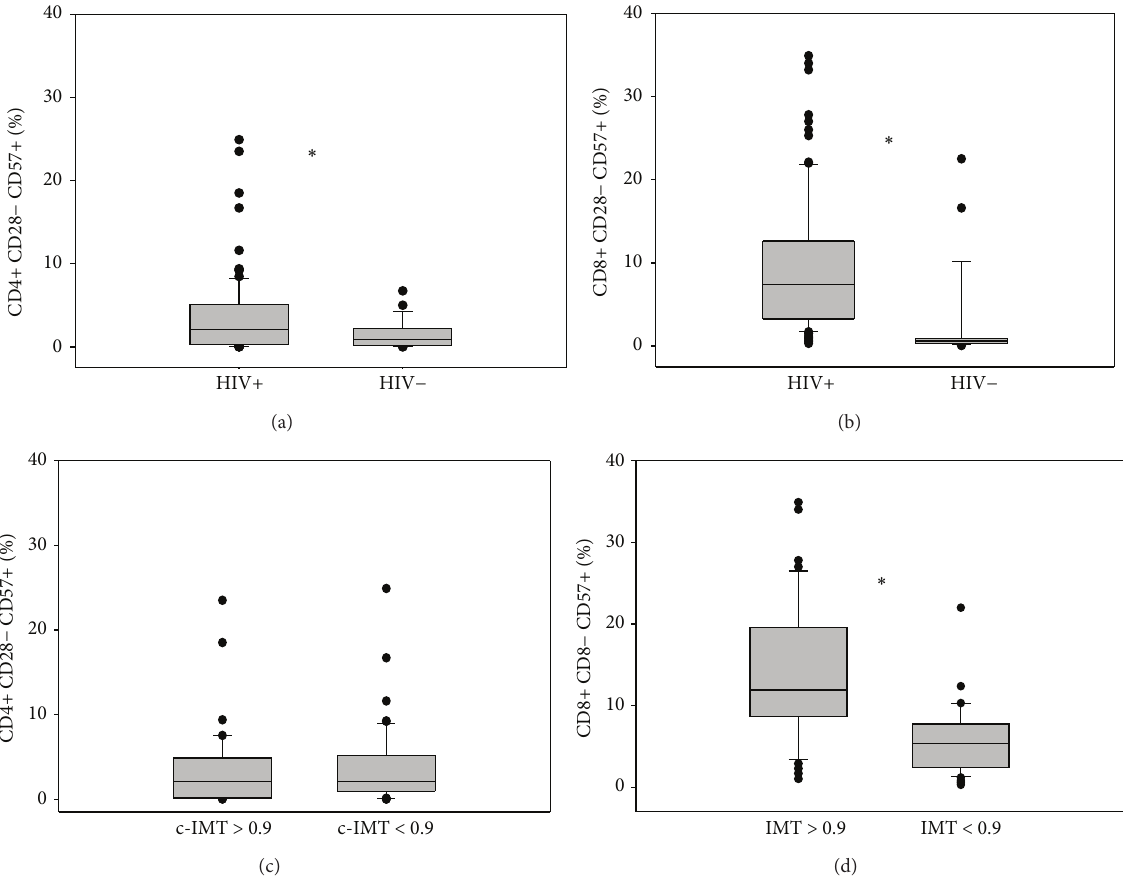
Figure 2: CD4+ (a) and CD8+ (b) immunosenescence in HIV-infected subjects compared with HIV-negative controls. CD4+ (c) and CD8+ (d) immunosenescence in HIV-infected subjects according to c-IMT. Values are expressed as percentage. Horizontal bars represent median. Upper and lower whisker mean third quartile +1.5 (interquartile range (IQR)) and first quartile-1.5(IQR). ∗ It represents a 𝑃 value < 0.05.